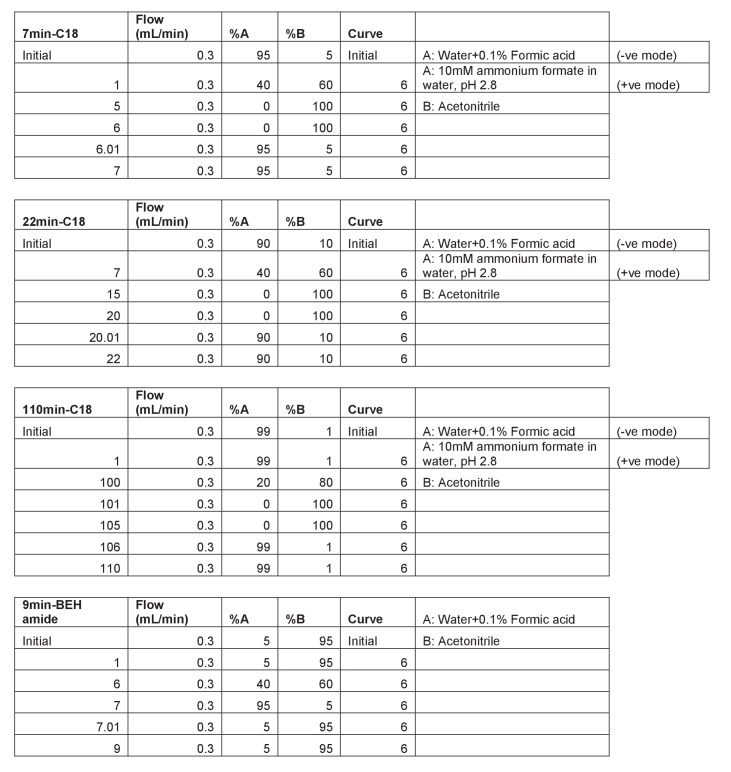
Description of the LC gradients used in this study.First column includes the method run time and the column used.